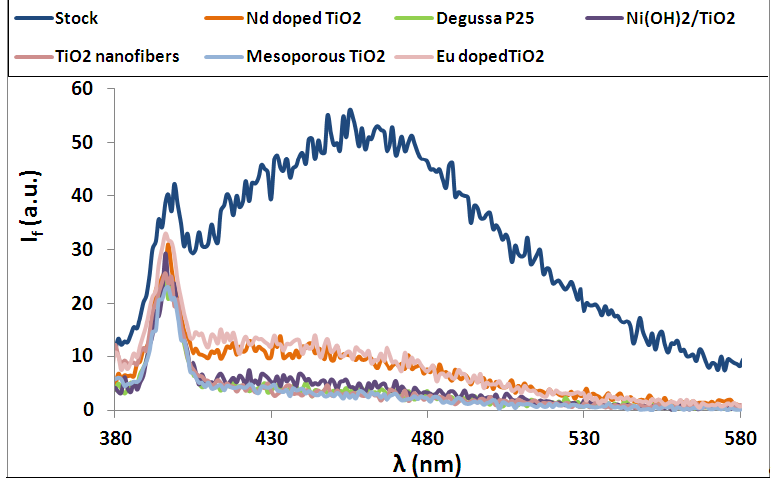
Figure 3. Final fluorescence spectra (3 times diluted samples) for λ 10 ppm FA solutions using 2.5 g/L of each photocatalyst after a light dose of 4.05 kJ/L (1 h) for runs in the 365 nm LED reactor (in case of Degussa P25, 2.25 kJ/L (0.5 h) was applied).